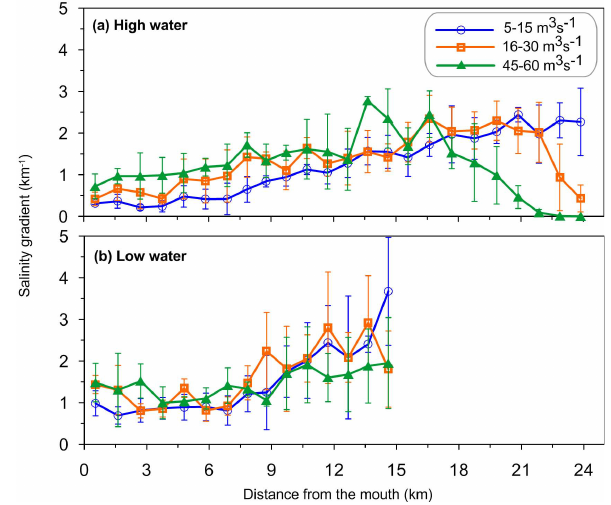
Fig. 2. Depth mean salinity distribution at high and low water slack in the Sumjin River Estuary under different river discharges.